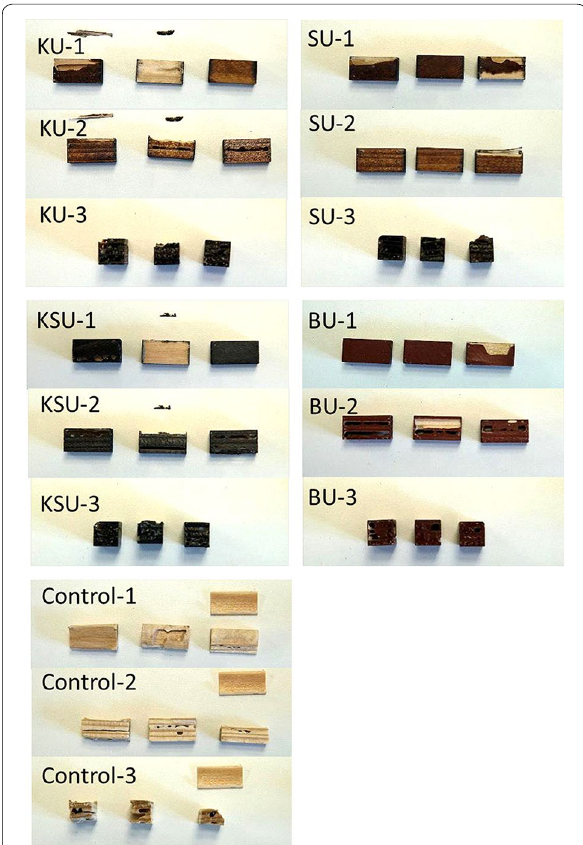
Fig. 2 The samples coated with each urushi after termite feeding test. 1 indicates the tangential surface, 2 indicates the radial surface, and 3 indicates the cross section